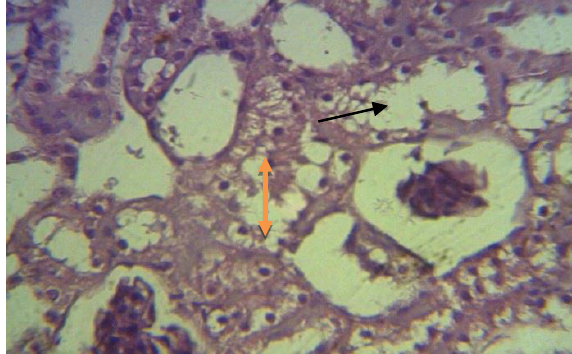
Fig. 5: Kidney of animal in T2 group 42 day post treated shows vacuolar degeneration of epithelial lining cells of renal tubules no clear (H and E stain 40x).